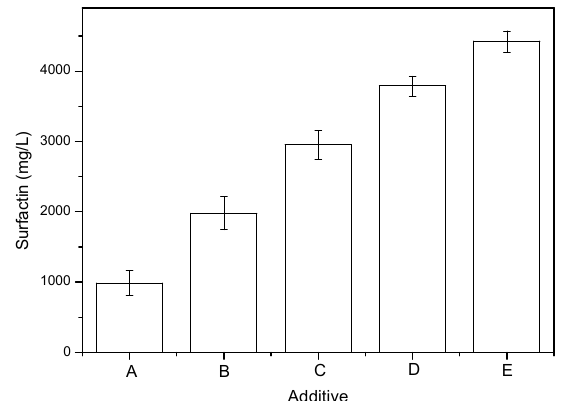
Figure 2. Effects of solid additives on surfactin yield in B. subtilis ATCC 21332 cultivation in a 5-day fermentation: ( A ) none; ( B ) MMT; ( C ) AC; ( D ) Mg 2 Al–LDH; ( E ) Mg 2 Fe–LDH. The surfactin level in the supernatant of the broth was determined. Error bars indicate the standard deviations from three tests.